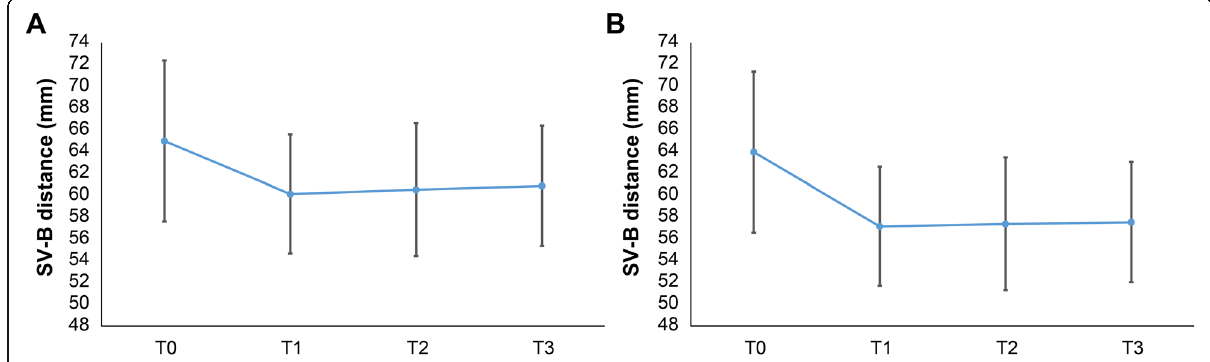
Fig. 3 SV-B distance change. a Group 1 (bilateral sagittal split ramus osteotomy [BSSRO]). b Group 2 (BSSRO + Le Fort I osteotomy). T0 before surgery, T1 2 months after surgery, T2 6 months after surgery, T3 1 year after surgery, SV-B the distance from the sella vertical plane to the B